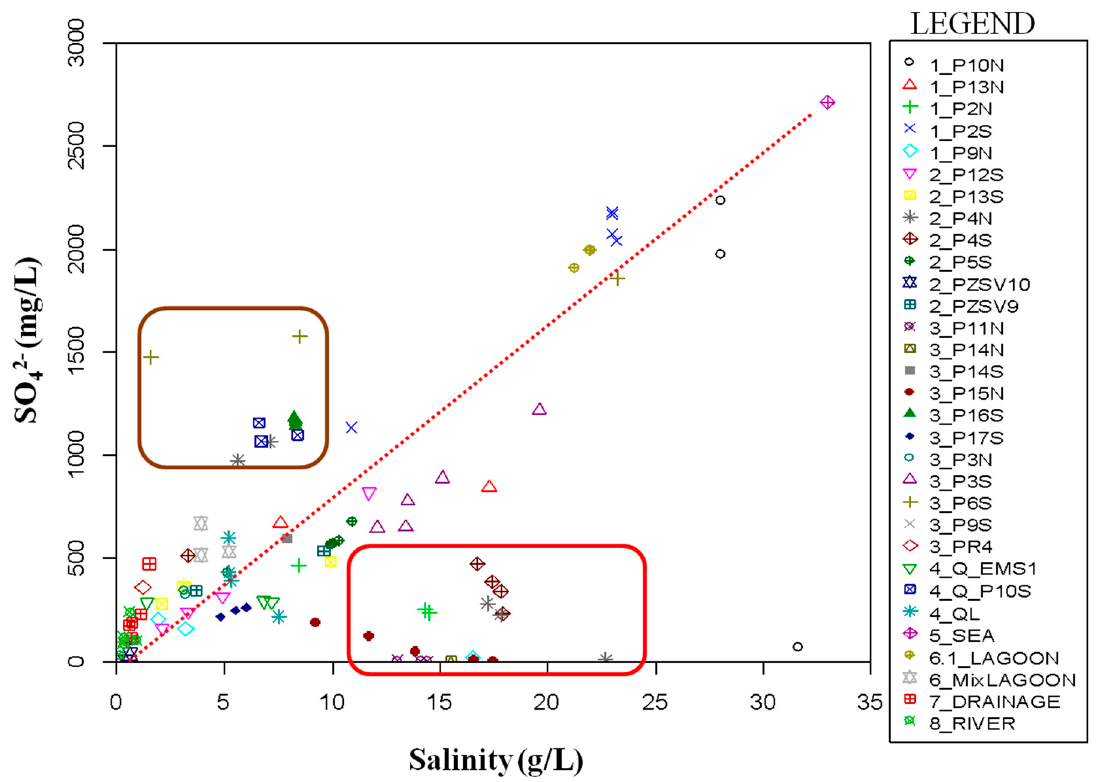
Figure 4. Binary plot of SO 42 − concentration vs salinity for all samples. Samples are grouped by environments (1–8, refer to Section environments (1–8, refer to Section 2.2).